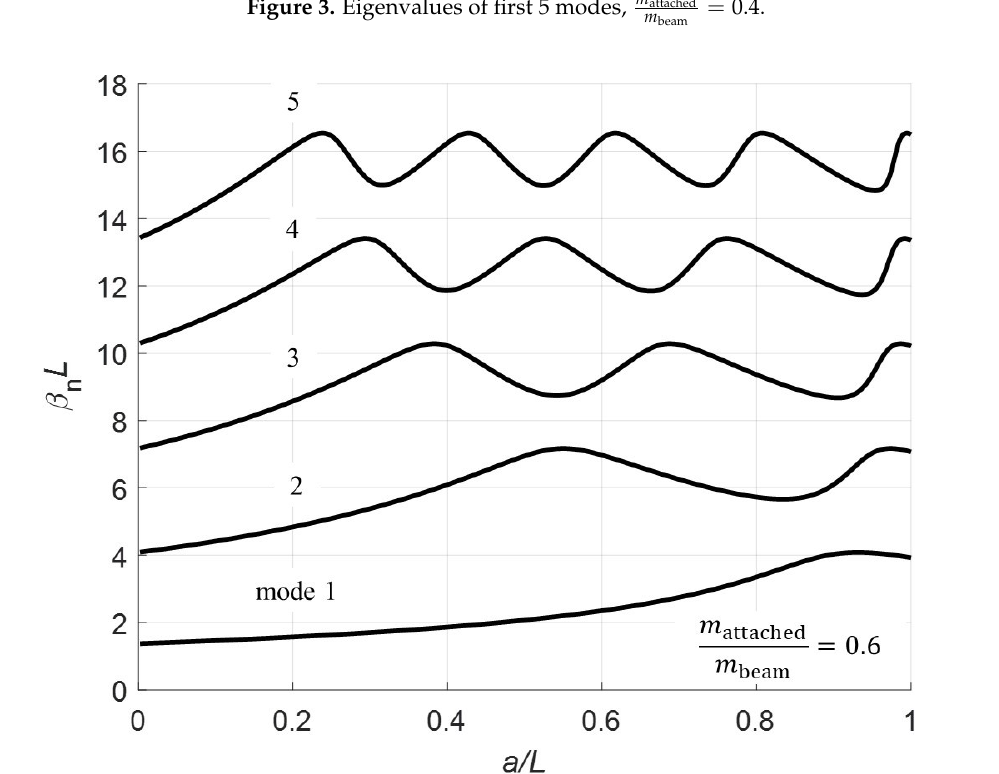
Figure 3. Eigenvalues of first 5 modes, m attached